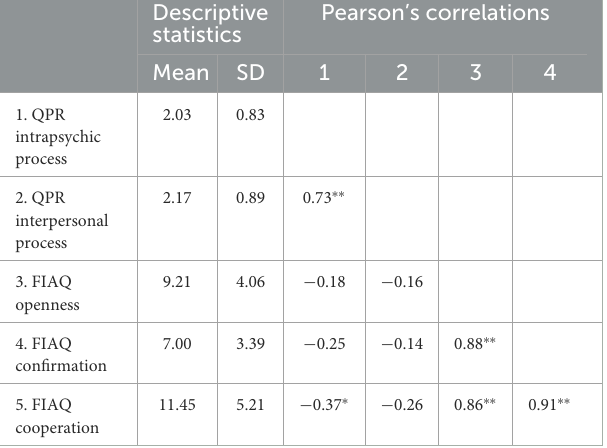
TABLE 3 The correlation matrix between the subscales of FIA-Q and QPR reported by carers ( n = 36). Descriptive